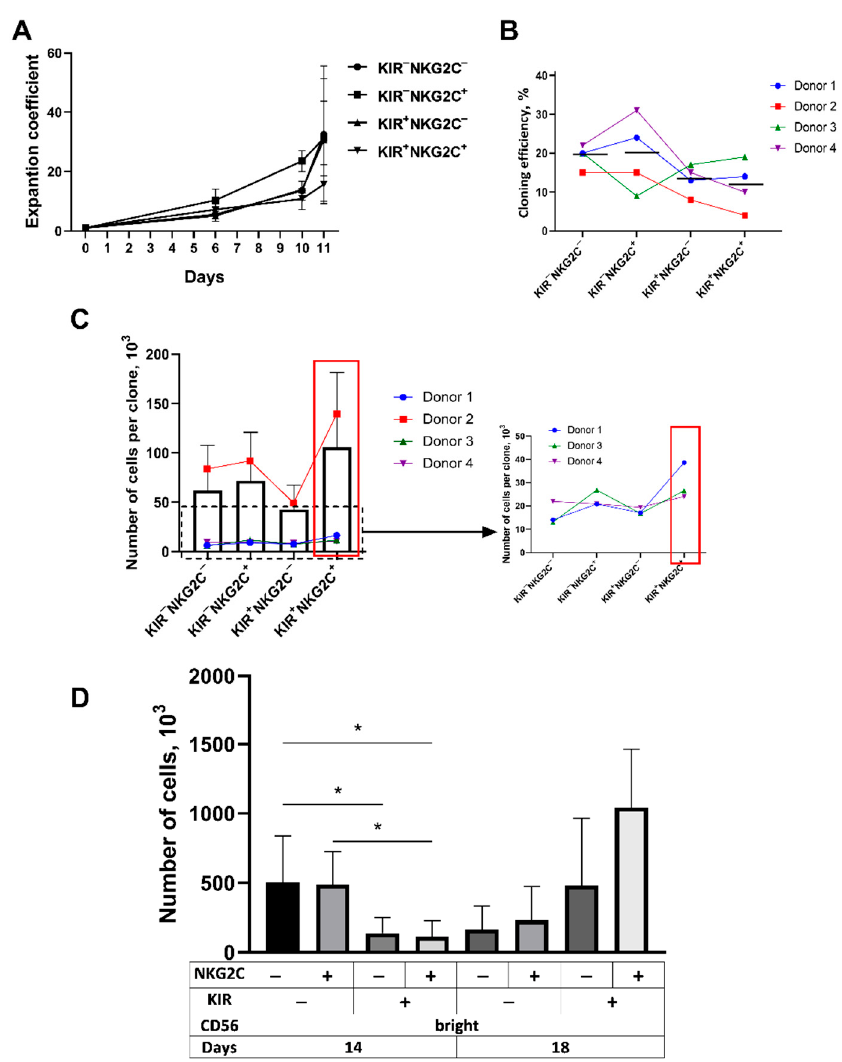
Figure 4. Proliferative activity of CD57 − NK cells differing in KIR2DL2/3 and NKG2C expression. ( A ) The expansion coefficient of the cultures obtained from CD57-negative KIR2DL2/3 +/ − NKG2C +/ − NK cells from four different donors. ( B ) Cloning efficiency of CD57 − KIR2DL2/3 +/ − NKG2C +/ − NK cells, measured after a 5-week stimulation with IL-2 and K562-mbIL21 feeder cells; black lines indicate means for four donors. The cloning efficiency was calculated as a percentage of the obtained clones from the total number of wells in which single NK cells were placed. ( C ) The average number of cells in a clone acquired from CD57-negative NK cell subsets after a 5-week stimulation with IL-2 and K562-mbIL21 cells, n = 4. ( D ) The average number of cells in CD56 bright subpopulations differing in the expression of KIR2DL2/3 and NKG2C on the 14th and 18th days of cultivation, n = 3. Statistical analysis was performed using a paired t -test (* p < 0.05); means ± SE are